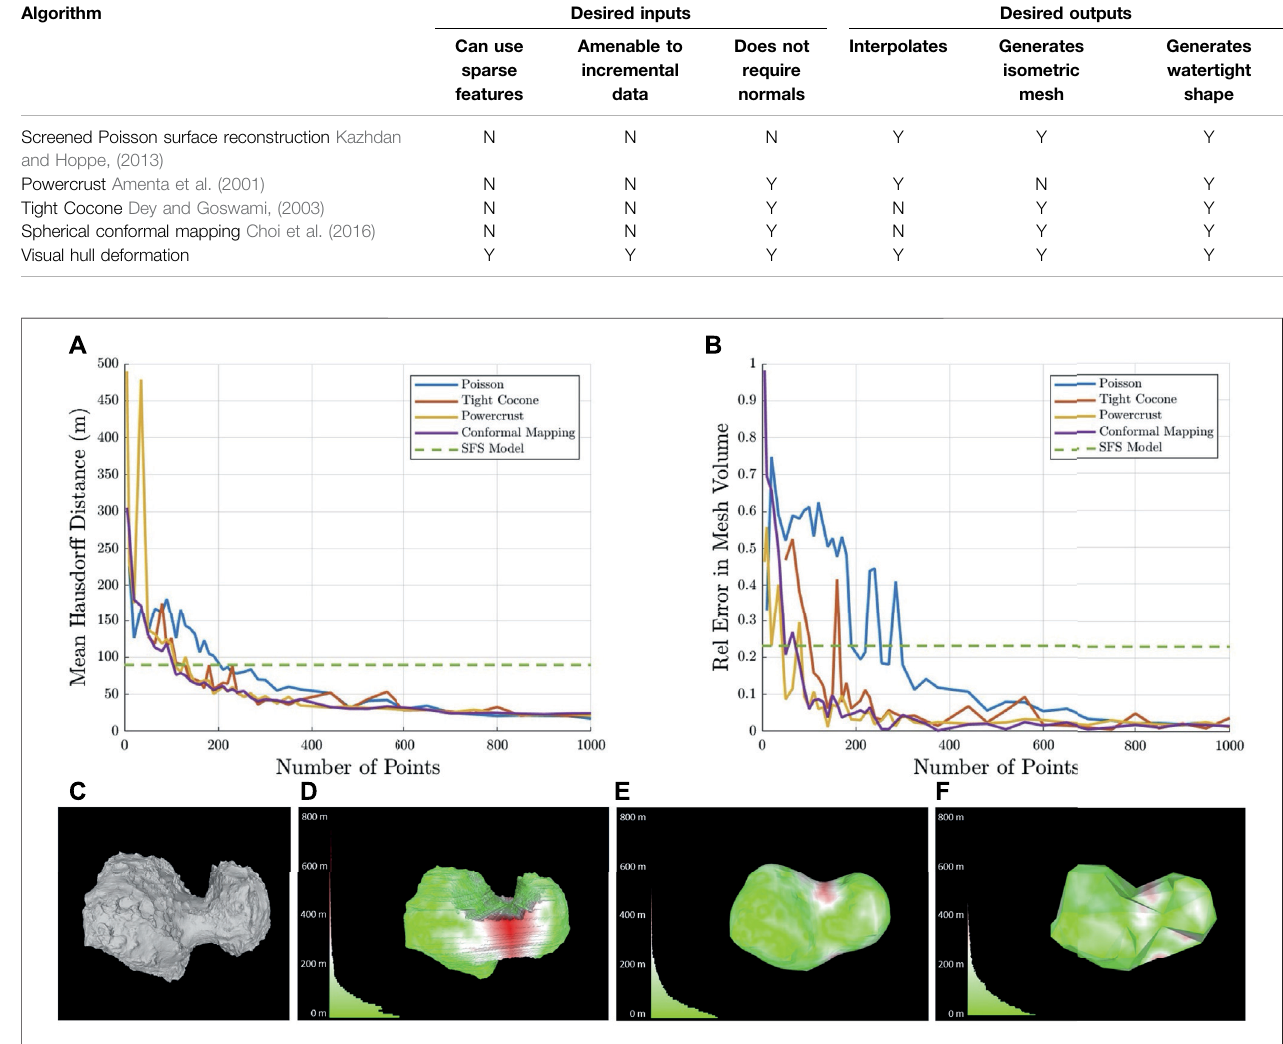
FIGURE 4 | Comparison of 3D coarse mapping algorithms with varying numbers of landmarks. (A) Mean Hausdorff distance. (B) Error in volume relative to the ground truth. Exampleofcoarsereconstruction ofcomet 67P with100 landmarks withcolored histograms ofdistanceto theground truth. (C) Ground truth, (D) shape- from-silhouette model, (E) Poisson surface reconstruction model, and (F) spherical conformal mapping